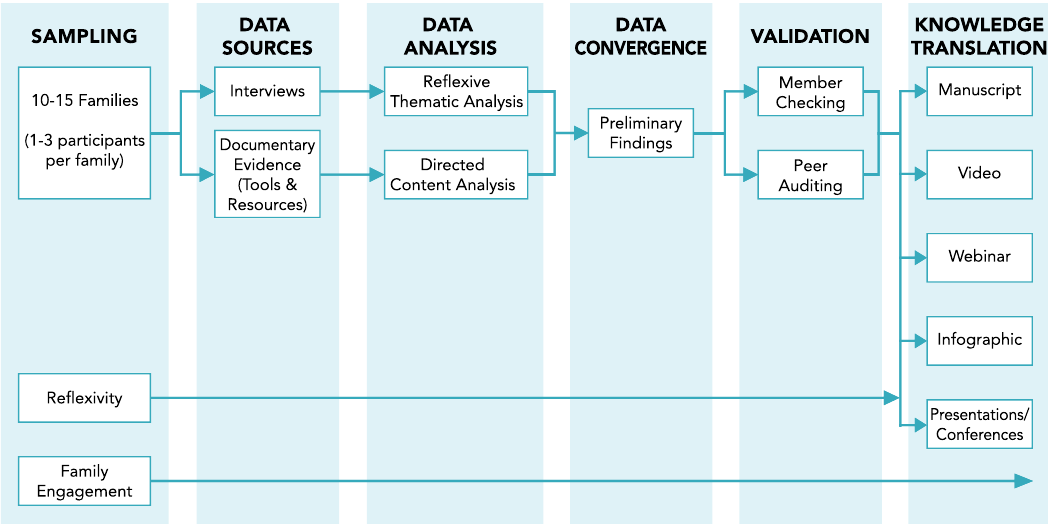
Figure 2: Methods flow